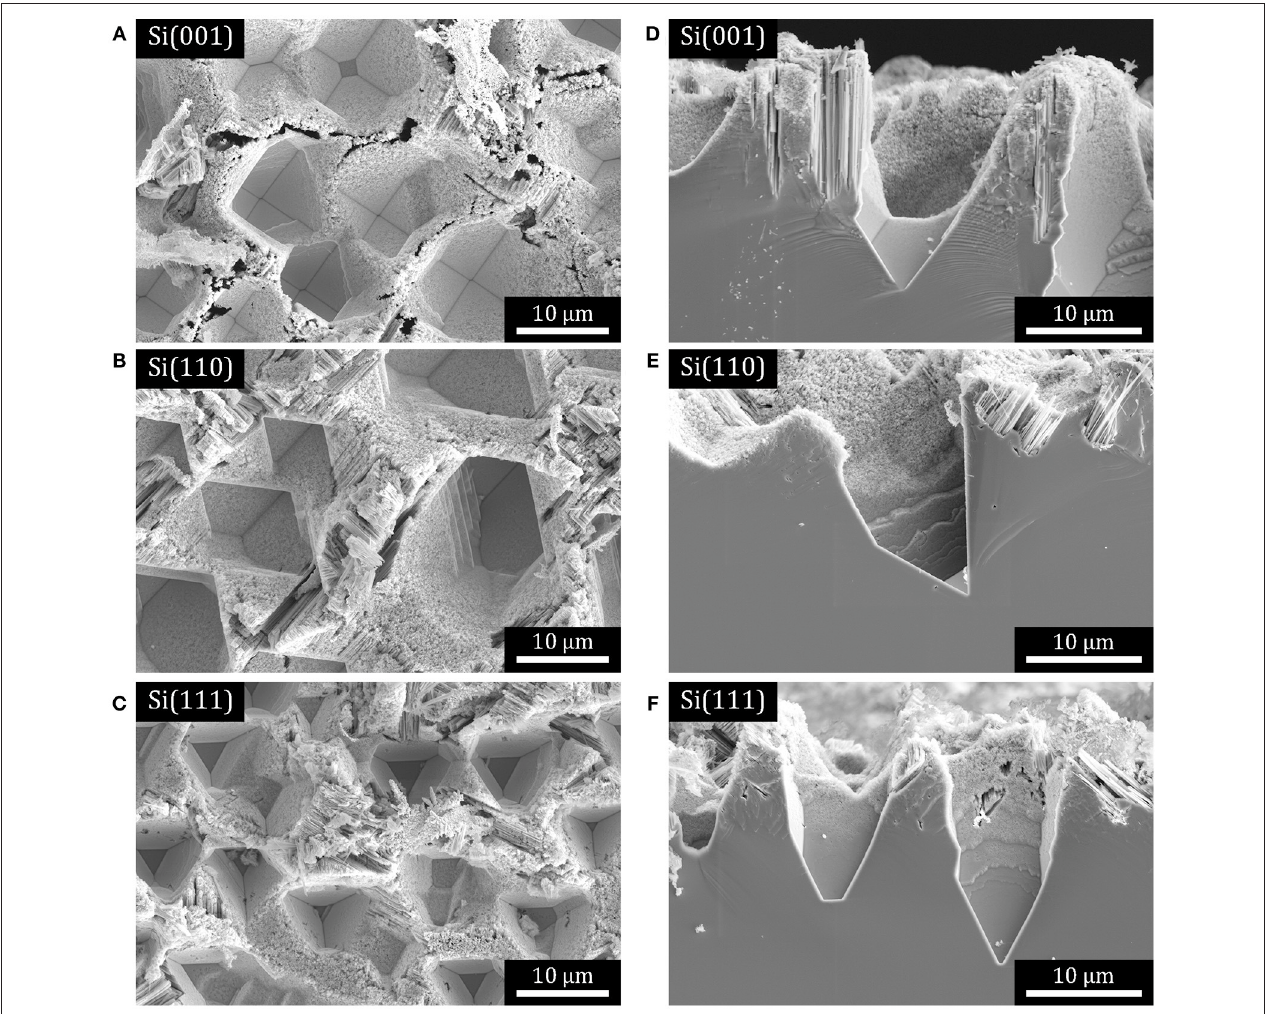
FIGURE 2 | SE SEM micrographs of macropores on Si substrates that have been subjected to Ag-catalyzed metal assisted etching in H 2 O 2 + HF solution. (A–C) Plan view micrographs of: (A) rectangular macropores on Si(001), (B) parallelepiped macropores on Si(110), and (C) triangular macropores on Si(111). (D–F) cross-sections of pores in the samples shown in (A–C) ,